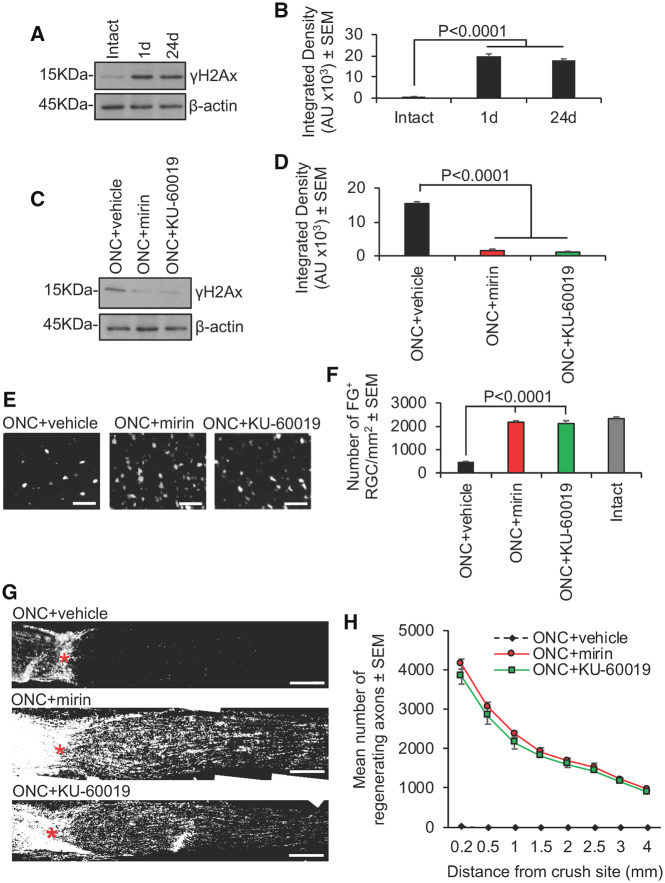

Inhibition of Mre11 and ATM prevents RGC apoptosis and stimulates axon regeneration at 24 days after optic nerve crush injury. (A) Western blot and (B) subsequent densitometry to show phosphorylation of H2Ax (γH2Ax) as a marker of DNA damage after optic nerve crush injury (n = 6 retinae/time point, three independent repeats (total n = 18 retinae/time point)). (C) Western blot and (D) densitometry to show that mirin and KU-60019 significantly suppress optic nerve crush injury-induced γH2Ax levels (n = 6 retinae/time point, three independent repeats (total n = 18 retinae/condition). (E) Representative images and (F) quantification of FluoroGold backfilled RGC in retinal wholemounts to demonstrate that mirin and KU-60019 significantly enhanced RGC survival at 24 days after optic nerve injury (n = 6 retinae/time point, three independent repeats (total n = 18 retinae/condition). (G) Representative images and (H), quantification to show that mirin and KU-60019 significantly enhanced RGC axon regeneration as detected by GAP43 immunoreactivity (n = 6 nerves/condition, three independent repeats (total n = 18 nerves/condition). AU = arbitrary units. Comparisons in B, D, F and H by one-way ANOVA with Dunnett’s post hoc test. Scale bars in E = 50µm and in G = 200 µm.